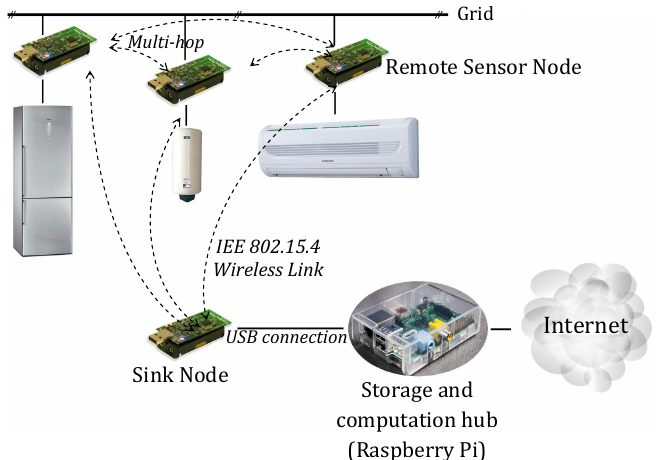
Figure 2. General wireless network